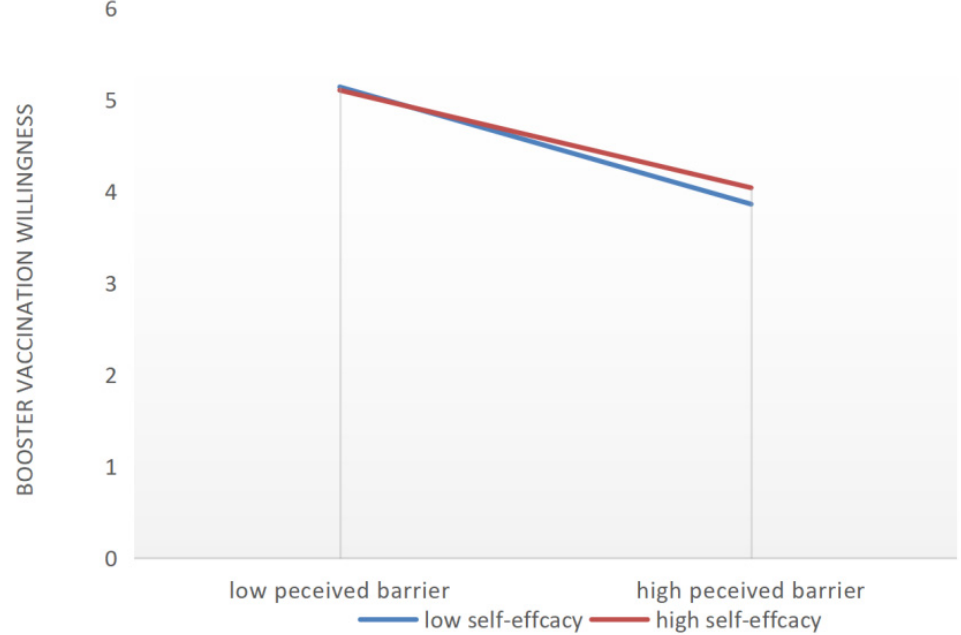
Figure 3. The moderating effects of self-efficacy on the relationship between perceived barriers and booster vaccination intentions.